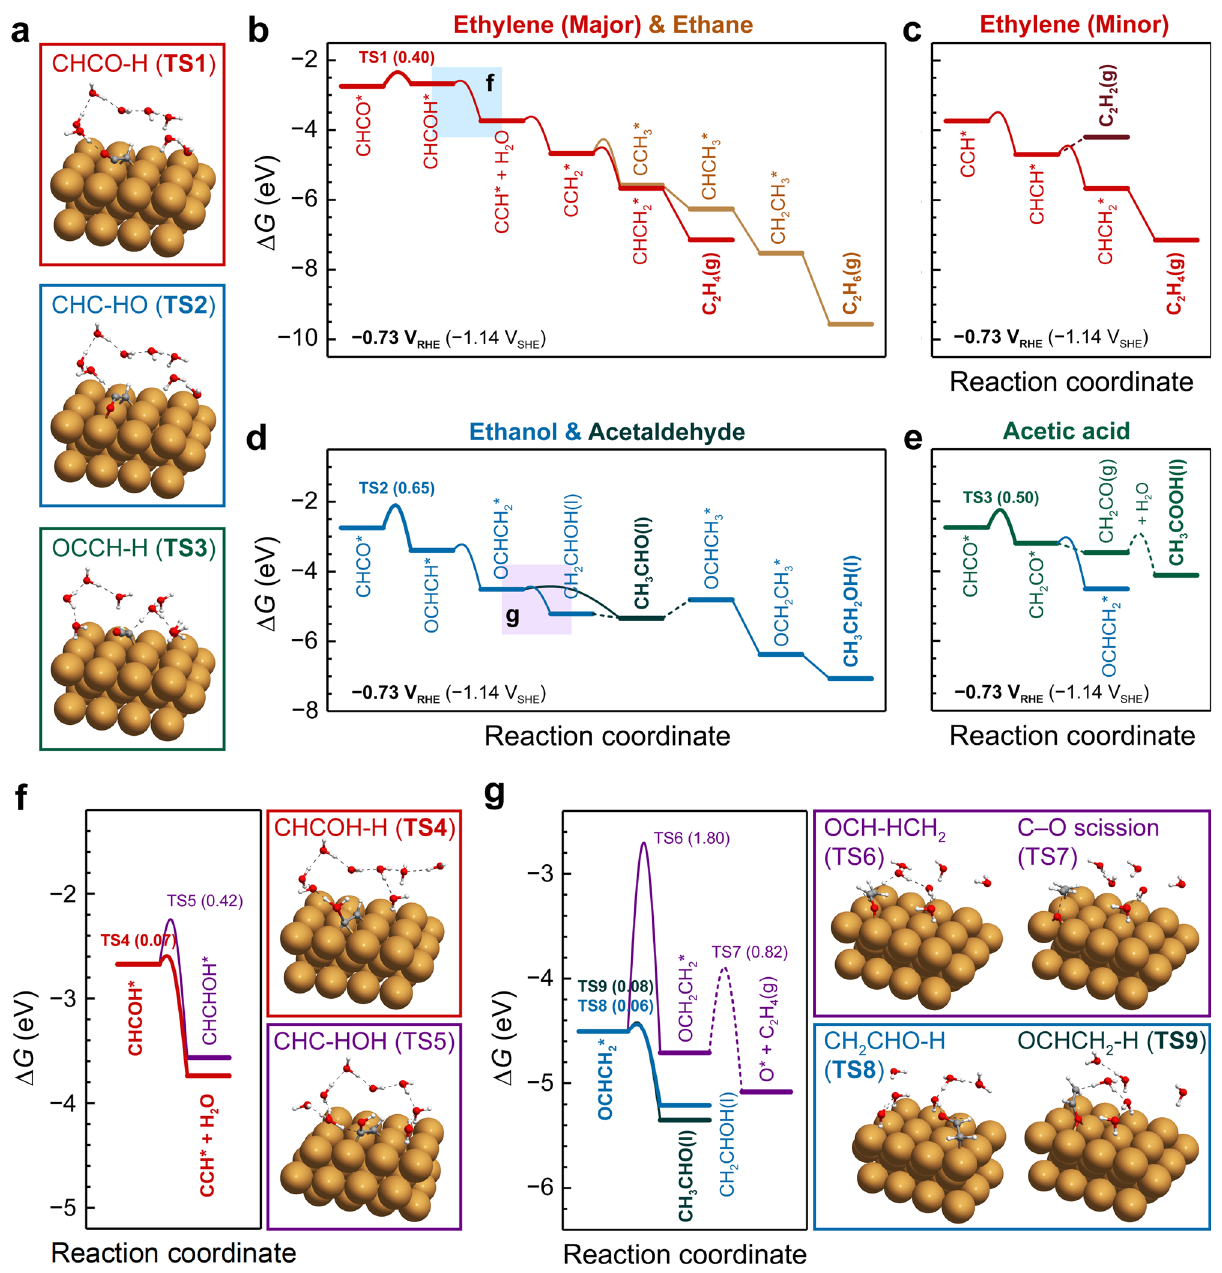
Fig. 2 Free energy diagrams (FEDs) of COR on Cu(100) at U RHE = − 0.73 V (pH7). a TS structures of CHCO-H (TS1), CHC-HO (TS2), and OCCH-H (TS3) protonation. FEDs showing b the major CHCOH pathway towards ethylene (red) and ethane (yellow), c the minor CHCOH pathway towards ethylene (red) and acetylene (brown), d the OCHCH pathway towards ethanol (blue) and acetaldehyde (navy), and e the CH 2 CO pathway towards acetic acid (green) and an intermediate (blue) leading to the other two C 2 Oxy products. The colored squares in b and d highlight regions where key competing reaction steps appear from branching pathways as illustrated in Fig. 1: f CHCHOH formation from CHCOH* (purple), possibly leading to C 2 Oxys and g ethylene formation from OCHCH 2 * (purple) as proposed by Calle-Vallejo et al. 26 and based only on the thermodynamic stabilities of surface species. Important TS structures, CHCOH-H (TS4) and CHC-HOH (TS5) protonation are shown in f , and OCH-HCH 2 (TS6), CH 2 CHO-H (TS8), and OCHCH 2 -H (TS9) protonation, as well as C – O scission of OCH 2 CH 2 * (TS7) are shown in g . Electrochemical protonation steps are shown as solid lines while chemical processes are shown as dashed lines. All energies in the FEDs are referenced to CO(g), H 2 (g), and H 2 O based on the computational hydrogen electrode (CHE) model. The values in parentheses in b – g represent the Δ G a at U RHE = − 0.73 V (pH7). Source data are provided as a Source Data fi absence of C 2 HC products, acetylene and ethane, observed via surface hydrogenation 35 . Since the C – O bond breaks easily through CHCOH-H protonation, the CHCOH pathway is con- experimentally may be attributed to the slower H-CCH protona- sequently identi fi ed to exclusively produce C 2 HCs. Once the tion and CCH 2 -H protonation steps compared to the steps CCH * is formed, a series of CH x CH y + 1 * intermediates ( x , y > 0) towards ethylene, i.e . CCH-H and H-CCH 2 , respectively. In follows, among which CCH * → CCH 2 * → CHCH 2 * → C 2 H 4 (g) is addition, the relatively strong binding strength of HCCH * limits shown to be the major pathway towards ethylene (Fig. 2b, c). The the desorption of acetylene and hence favors subsequent reduction.